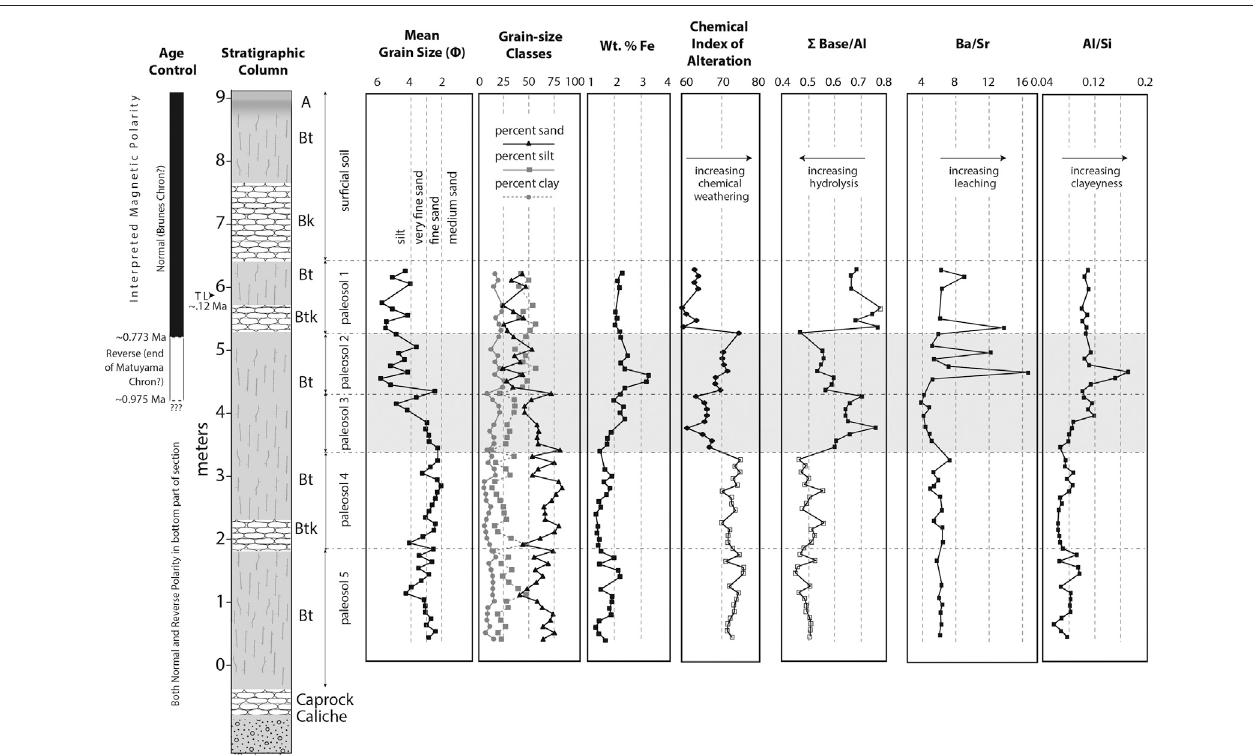
FIGURE 2 | Integration of sedimentologic, geochemical, and geochronologic data from the type section of the BDF. Horizontal lines represent soil boundaries. Grain-size data are reported in relative proportions of sand, silt, and clay. Geochemical samples were acid leached to remove calcium carbonate so that silicate weathering could be accurately assessed. Chemical index of alteration (CIA) is after (Nesbitt and Young, 1982). This fi gure also includes Wt % Fe vs depth, which was constructed using Table 1 from (Stine et al., 2020) note how Paleosol 2 has the highest percentage of Fe. (Stine et al., 2020) noted that the anonymously high CIA and Σ Base/Al values for Paleosol 4 and 5 were due to the high quartz content rather than high weathering and hence are represented with open squares. Nevertheless, CIA and Σ Base/Al values for the other paleosols are more representative of relative weathering intensity, and are represented with closed squares. Magnetic polarity is from (Patterson andLarson,1990),andagecalibrationisfrom(Singer, 2014).Shaded graybackgroundisthepart ofthesectionthatcloselyalignswiththeapproximate duration (1250 – 700 ka) of the mid-Pleistocene transition from (Clark et al., 2006). TL — thermoluminescence-obtained date, from (Holliday, 1989). The stratigraphic position of the TL -date within Paleosol 1 is uncertain, hence it is currently interpreted to represent the minimum age of Paleosol 1. Soil horizon nomenclature follows standard (Soil Survey Staff, 1990) procedures. Figure modi fi ed from (Stine et al., 2020).